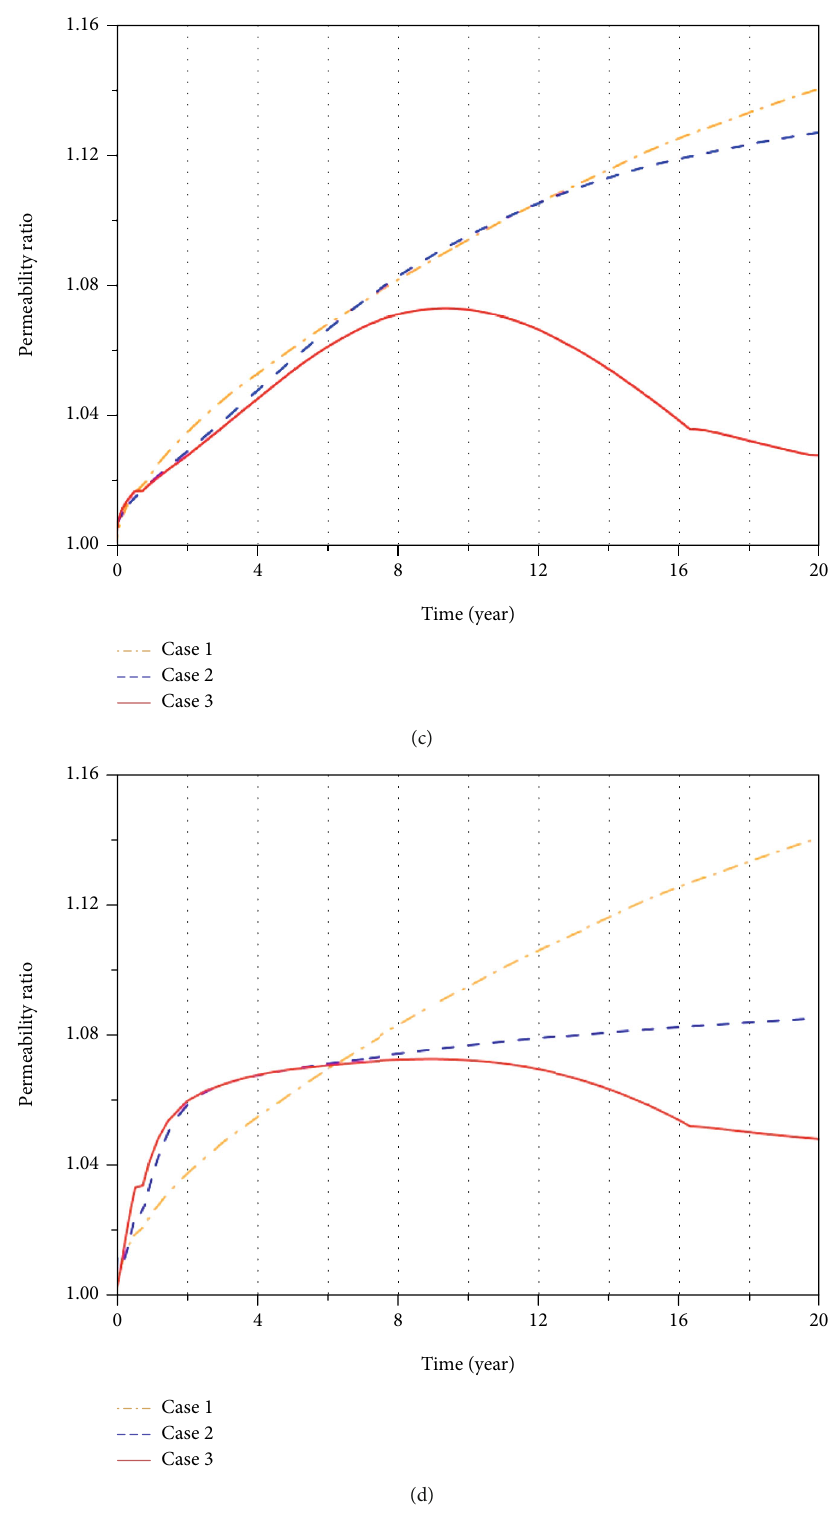
Figure 14: The temporal evolution of permeability ratio for three di ff erent cases at (a) MP1, (b) MP2, (c) MP3, and (d)